Question: Express in one sentence what the figure is showing.
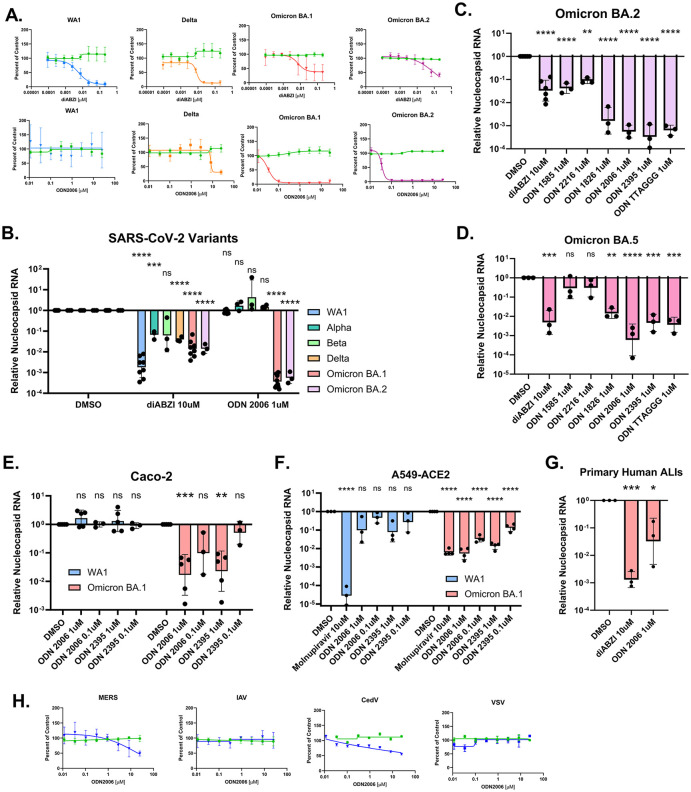
Answer: Oligodeoxynucleotides inhibit diverse SARS-CoV-2 Omicron variants. (A) Calu-3 cells were pre-treated with indicated agents in 8-pt dose-response for 2h and infected with SARS-CoV-2 variants (MOI 0.5) for 48 hours. Cells were processed for automated microscopy and image analysis quantifying total cell numbers (green) and percent infection (dsRNA + /nuclei+) to determine Percent-of-Control (POC) % positive. Each data point represents the mean±SD n = 3-6 independent biological replicates. (B, C) Calu-3 cells were pre-treated with vehicle (DMSO), diABZI positive control, or ODN2006 for two hours and infected with SARS-CoV-2 variants (MOI 0.2) for 48 hours prior to processing for RT-qPCR analysis of viral RNA (Nucleocapsid). (D) Calu-3 cells were pre-treated with diABZI positive control or ODNs for 1 hour followed by SARS-CoV-2 Omicron BA.5 (MOI 0.2) infection for 48 hours. Cell lysates were processed for RT-qPCR analysis of viral RNA (Nucleocapsid). (E) Caco-2 and (F) A549-ACE2 cells were pre-treated with the indicated compounds for 1 hour followed by SARS-CoV-2 WA1 or Omicron BA.1 (MOI 0.2) infection for 48 (Caco-2) or 24 (A549-ACE2) hours. Cell lysates were processed for RT-qPCR analysis of viral RNA (Nucleocapsid). (G) Primary human bronchial air-liquid interface (ALI) cells were pre-treated with DMSO vehicle, diABZI positive control, or ODN 2006 1uM for 1 hour followed by SARS-CoV-2 Omicron BA.1 (MOI 0.2) infection for 72 hours. Cell lysates were processed for RT-qPCR analysis of viral RNA (Nucleocapsid). Mean±SD with individual biological replicates shown. Significance for relative viral RNA was calculated using One Way ANOVA with Dunnett Correction for multiple comparisons (*p < 0.05, **p < 0.01, ***p < 0.001, ****p < 0.0001; ns, no significance). (H) Calu-3 cells were pre-treated with ODN2006 in 8-pt dose-response for 2h and infected with MERS-CoV (MOI 0.3; 24 hours), IAV (MOI 1; 24 hours), CedV (MOI 0.4; 24 hours), and VSV (MOI 0.05; 24h). Cells were processed f